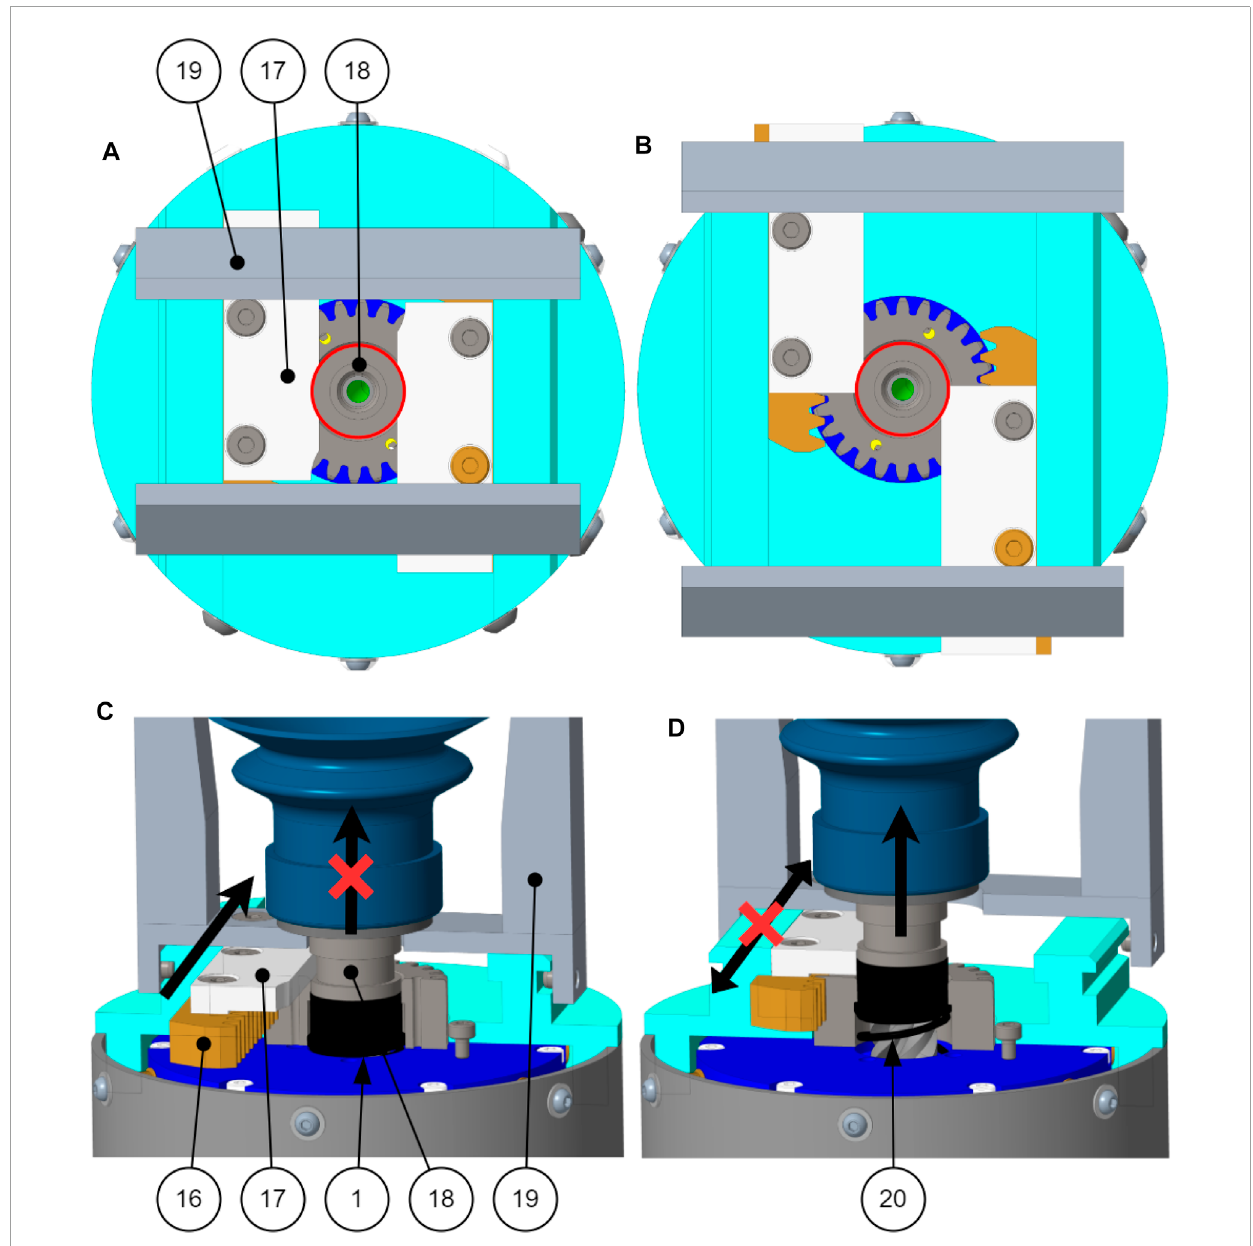
FIGURE 9 End stops mechanism (A) Phase 1 and 4 in top view. (B) Phase 2 and 3 in top view. (C) Phase 1 and 4. (D) Phase 2 and